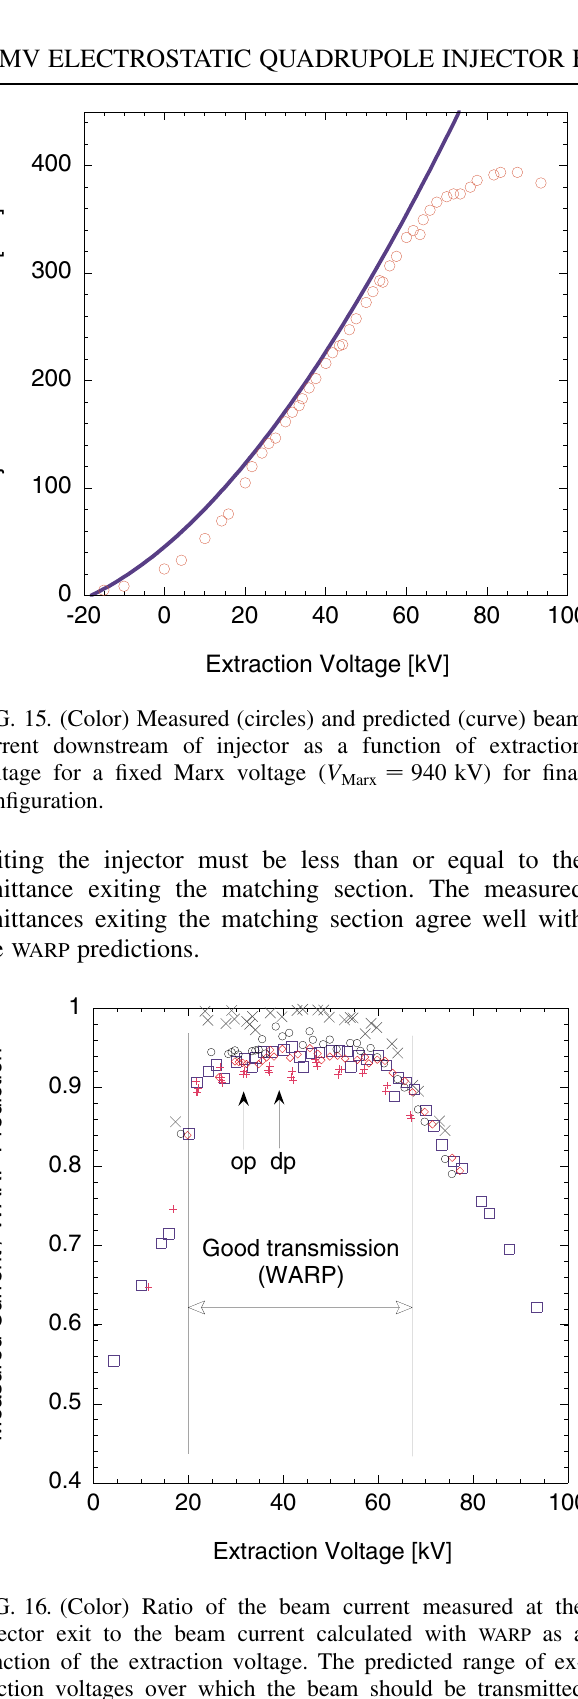
FIG. 16. (Color) Ratio of the beam current measured at the injector exit to the beam current calculated with WARP as a function of the extraction voltage. The predicted range of ex- traction voltages over which the beam should be transmitted without touching the wall is indicated. The operating point ‘‘op’’ and design point ‘‘dp’’ are indicated. Several series of measure- ments taken over a period of more than a year are shown.